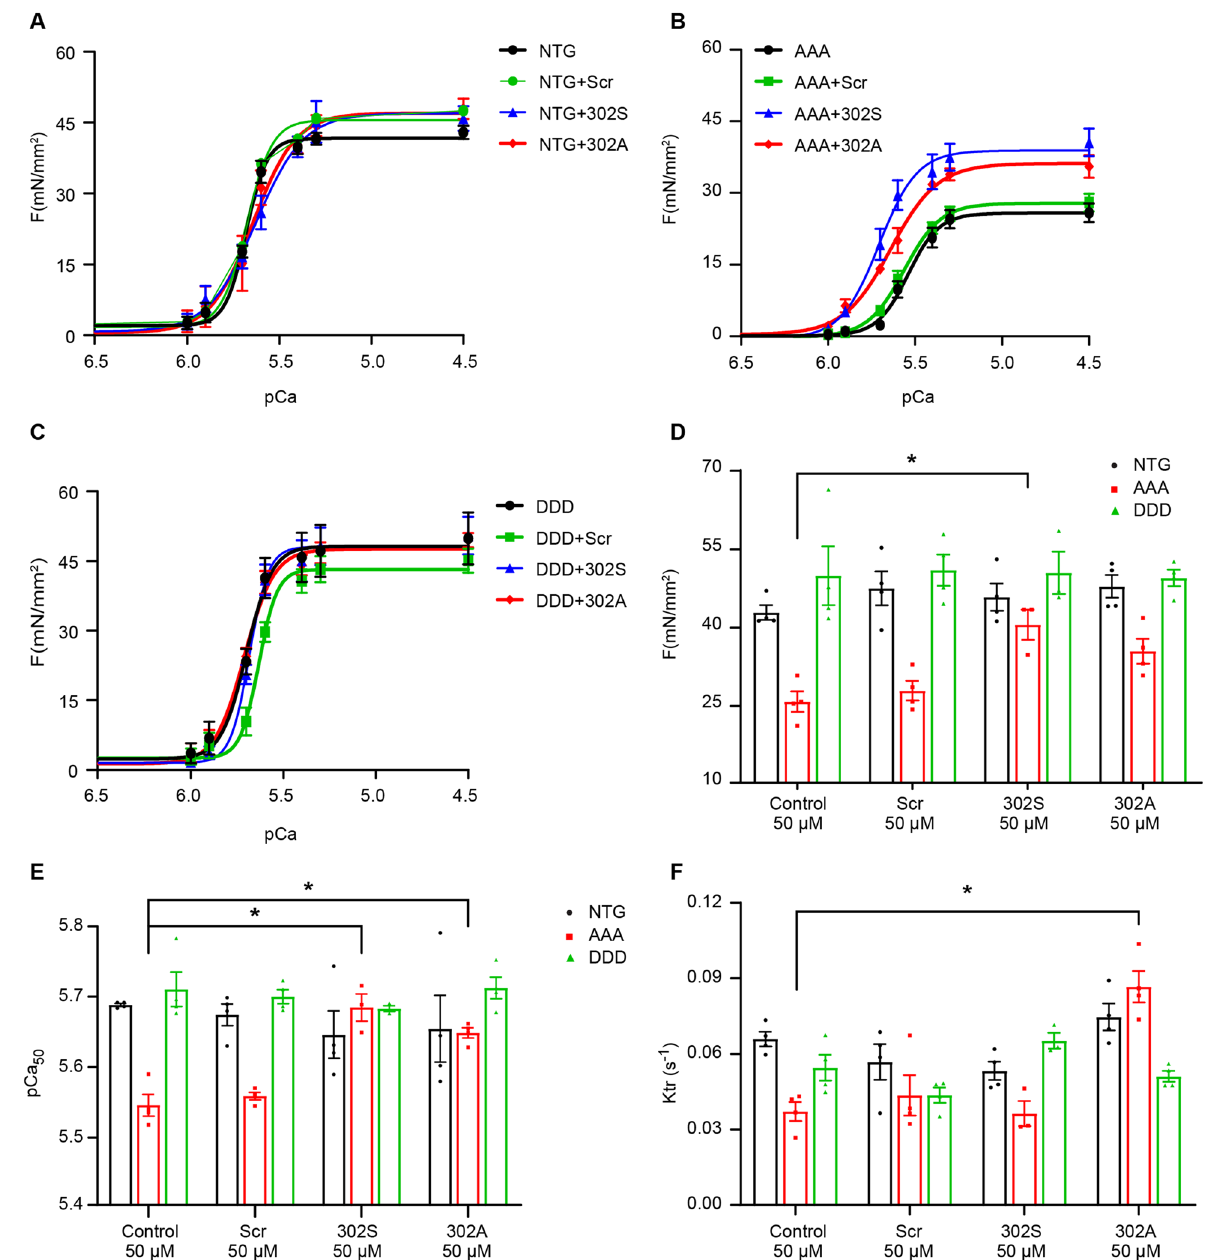
Figure 6. Cardiac function was improved by cMyBP-C peptides 302A and 302S in muscle fibers isolated from AAA transgenic mice, but not in NTG or DDD TG mice. Force pCa curves ( A – C ) generated at sarcomere length 2.0 μM in the presence of different peptides (50 μM). Maximum force production ( D , mN/mm 2 ), calcium sensitivity ( E , pCa 50 ), and rate of force regeneration ( F , k tr ) were measured in the presence of different peptides (50 μM) in NTG (white bar), AAA (red bar) and DDD (green bar). N = 4 papillary fibers per peptide treatment from 4 animals per group. * p < 0.05 one-way ANOVA with Tukey post-test. AAA, nonphosphorylated alanines; DDD, phospho-mimetic aspartic acids; NTG, non-transgenic mice. Scr,